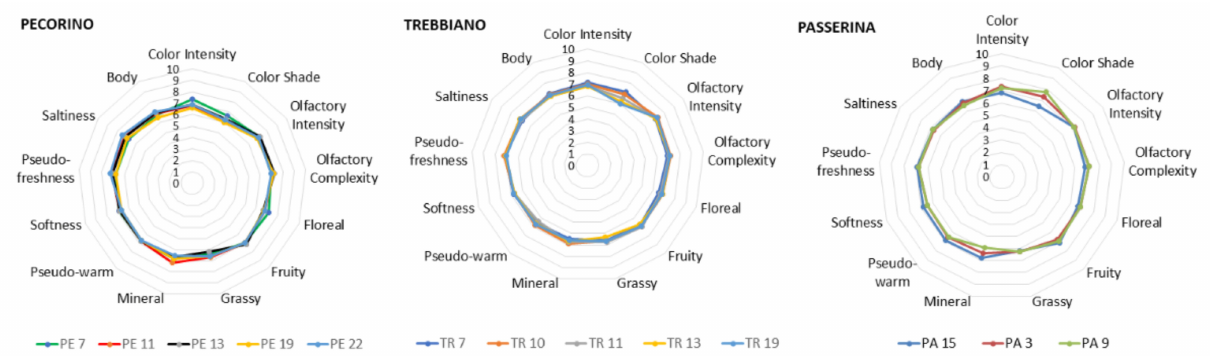
Figure 3. Sensory profiles of representative, from top to bottom, Pecorino (PE), Trebbiano d’Abruzzo (TR), and Passerina (PA) wines. The number refers to the production site, as reported in Figure